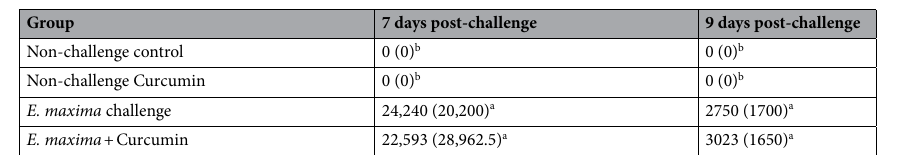
Table 3. Eimeria maxima oocyst per gram in the feces of specific pathogen-free Leghorn chickens at 7- and 9-days post-challenge. Each value represents the mean (median). a,b Values within groups columns with different superscripts differ significantly at P <